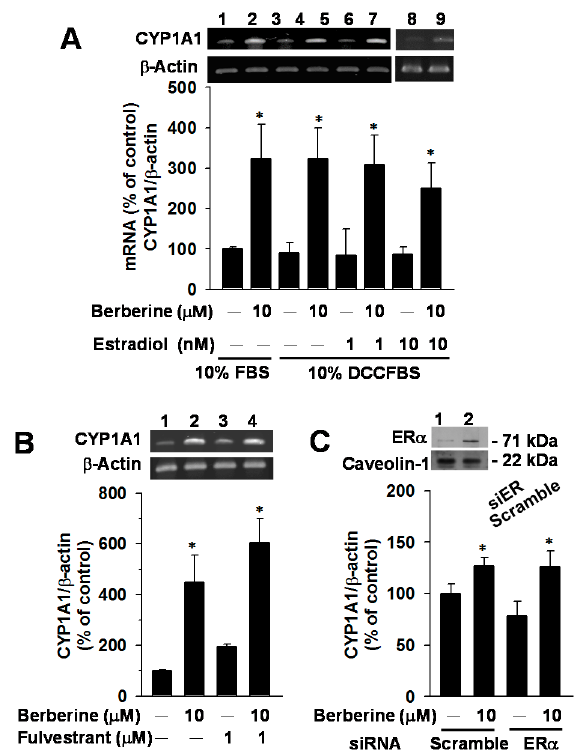
Figure 4. Effects of estradiol ( A ), fulvestrant ( B ) and ER α knockdown ( C ) on the mRNA levels of CYP1A1 and CYP1B1 in vehicle control and berberine-exposed MCF-7 cells. In panel ( A ), cells were cultured in the medium supplemented with 10% FBS or 10% DCCFBS, as indicated. The mRNA levels of CYP1A1 and β -actin were determined using RT–PCR analysis followed by gel electrophoresis. In panels ( B , C ), cells were exposed to berberine and/or fulvestrant in a 10% FBS-supplemented medium. In panel ( C ), cells were transfected with scramble and ER α siRNA in a serum-free medium. After 6 h, the medium was replaced by a FBS-supplemented medium. Cells were cultured in the incubator for 18 h and then exposed to berberine for 24 h. Cell lysates were prepared and subjected to the immunoblot analysis as described in the Materials and Methods. The level of caveolin-1 was determined as the control for loading equal amount of protein of lysate. The representative blot is shown on the top. Data represent the mean ± SD of 3 separate experiments with 4 determinations in each experiment. * p < 0.05, compared with the cells without berberine-treatment.